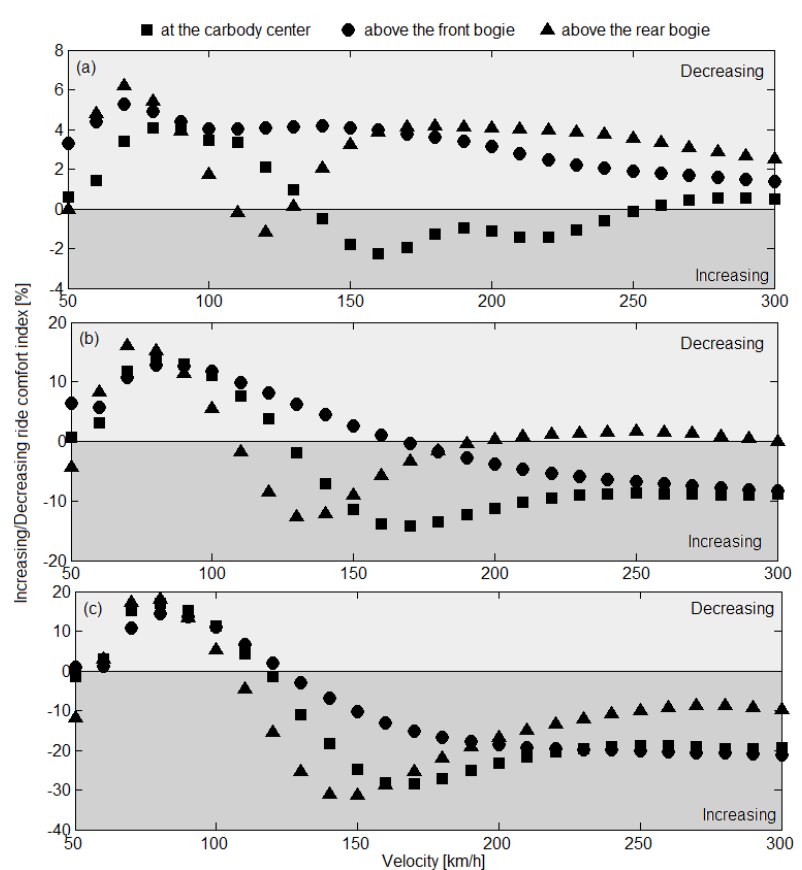
Figure 15. Influence of the increase in the mounting angle of the anti-yaw damper upon the ride comfort index: ( a ) c = 1·10 5 Ns/m; ( b ) c = 5·10 5 Ns/m; ( c ) c = 1·10 6 Ns/m.